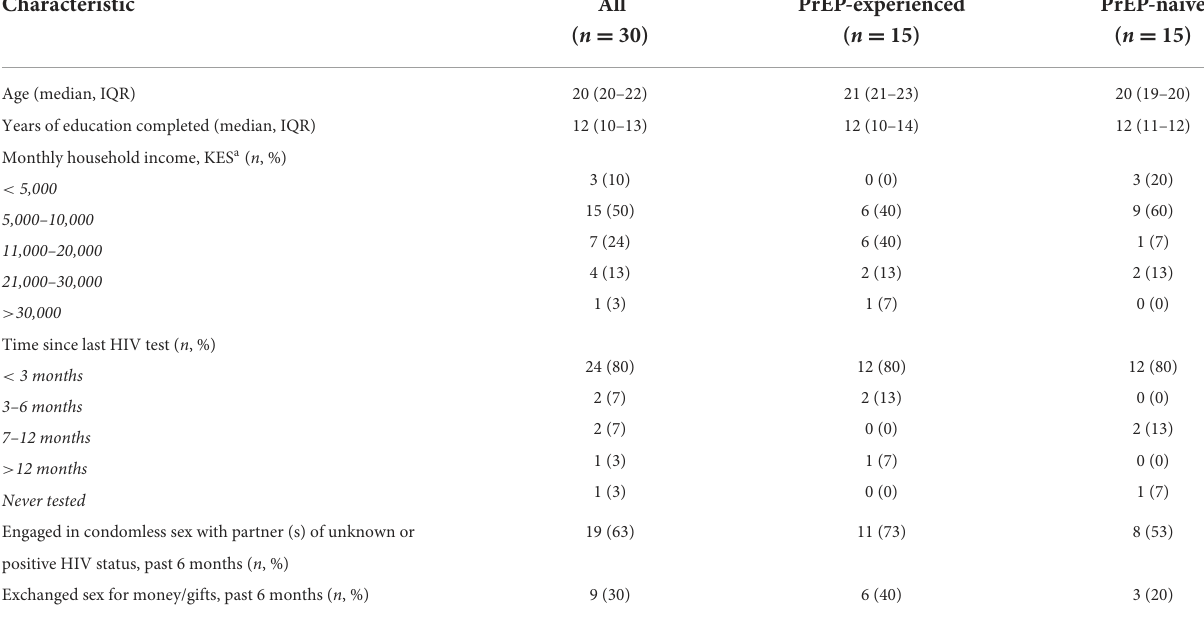
TABLE 1 Demographic characteristics of